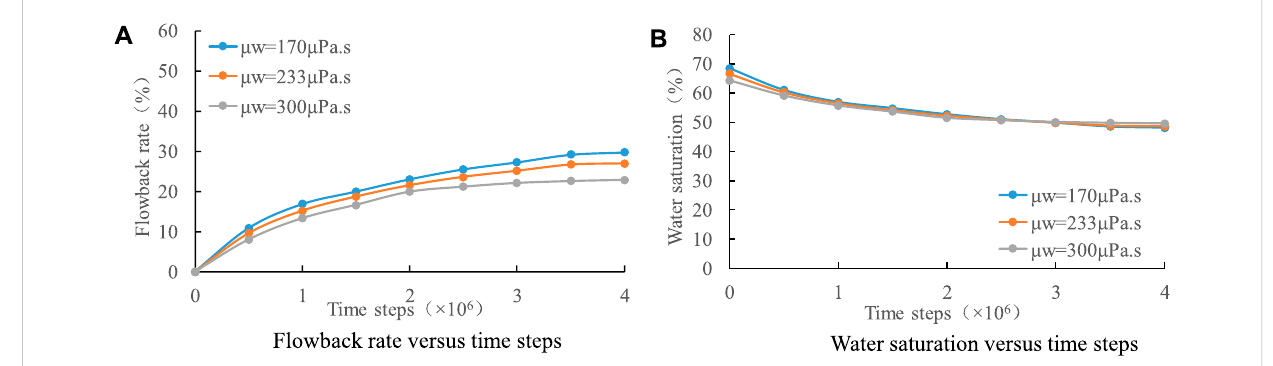
FIGURE 25 The fl owback rate versus time steps (A) and the water saturation versus time steps (B) in the fl owback process under different fracturing fl uid